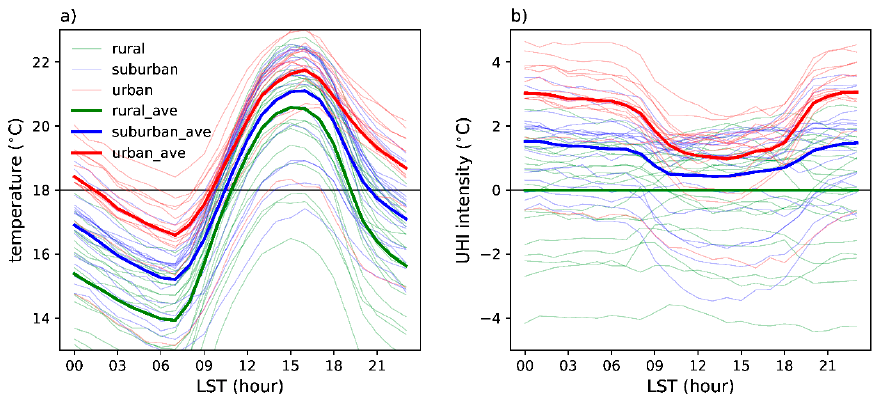
Figure 3. Mean diurnal cycle of ( a ) temperature (°C) and ( b ) urban heat island (UHI) intensity (°C) at each AWS in 2017. The red, blue and green lines indicate urban, suburban, and rural sites, respectively. Thin lines are variations of individual sites and thick lines are the averages of sites in certain categories.